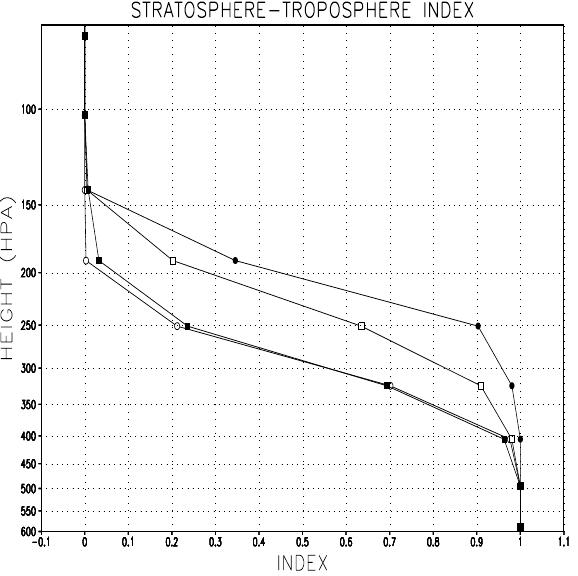
Fig. 1. Seasonal mean vertical index profiles of the stratosphere (de- noted as 0), troposphere (denoted as 1), and the transient movement Figure1.Seasonalmeanverticalindexpro(cid:12)lesofthestratosphere(denotedas0),troposphere of the tropopause in the UTLS region (denoted as values between 0 and 1) for the NH spring (open circles), summer (solid circles), (denotedas1),andthetransientmovementofthetropopauseintheUTLSregion(denotedas autumn (open squares), and winter (solid squares) calculated at a location in the NH (40 ◦ N, 105 ◦ valuesbetween0and1)fortheNHspring(opencircles),summer(solidcircles),autumn(open ÆN,105 ÆW). squares),andwinter(solidsquares)calculatedatalocationintheNH(40